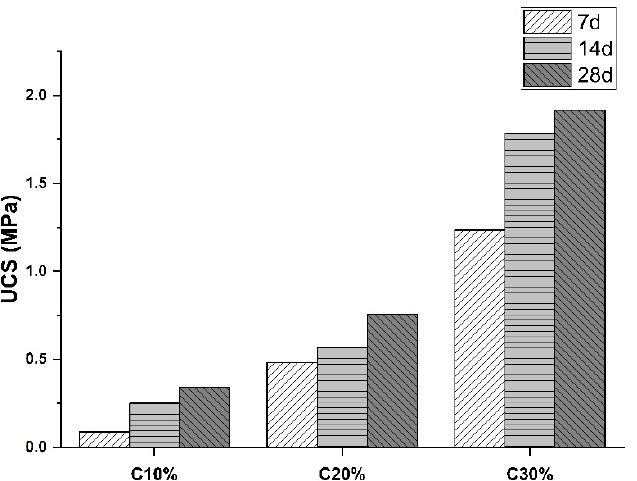
Figure 1. Compressive strength enhancement for the control group (Note: C represents Portland cement).